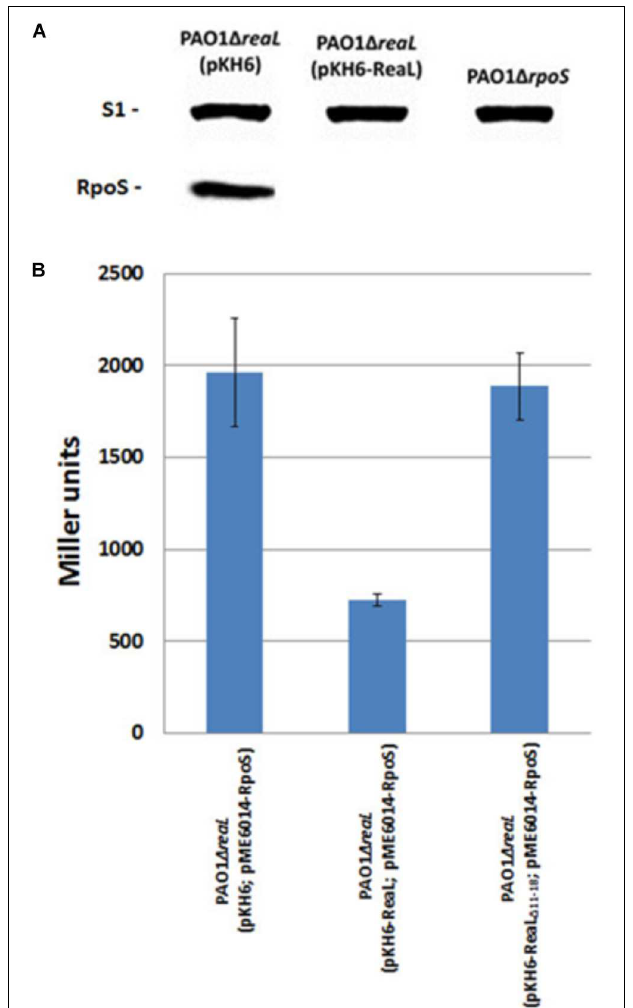
FIGURE 3 | RpoS synthesis is repressed by ReaL. (A) The strains PAO1 (cid:49) reaL (pKH6), PAO1 (cid:49) reaL (pKH6-ReaL), and PAO1 (cid:49) rpoS were grown in LB medium. At an OD 600 of 1, ReaL synthesis was induced by addition of L -arabinose (final concentration 0.2%). Samples for quantitative Western-blot analysis were withdrawn 30 min after reaL induction. The strains are indicated on top. The position of RpoS and ribosomal protein S1 (loading control) are indicated at the right. (B) The strains PAO1 (cid:49) reaL (pKH6; pME6014-RpoS), PAO1 (cid:49) reaL (pKH6-ReaL; pME6014-RpoS), and PAO1 (cid:49) reaL (pKH6-ReaL (cid:49) 11 − 18 ; pME6014-RpoS) were grown in LB medium. At an OD 600 of 2.5, ReaL synthesis was induced by addition of L -arabinose (final concentration 0.2%). Samples for β -galactosidase activity measurements were withdrawn 30 min after ReaL induction. The values shown were derived from three independent experiments. The error bars represent standard